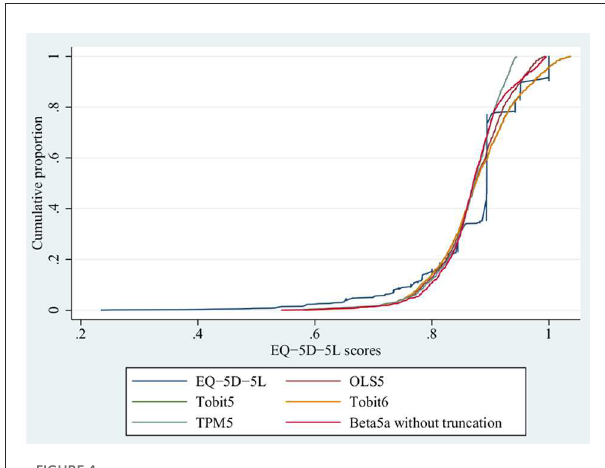
FIGURE4 Estimation of conditional distribution function of EQ-5D-5L with the better models.